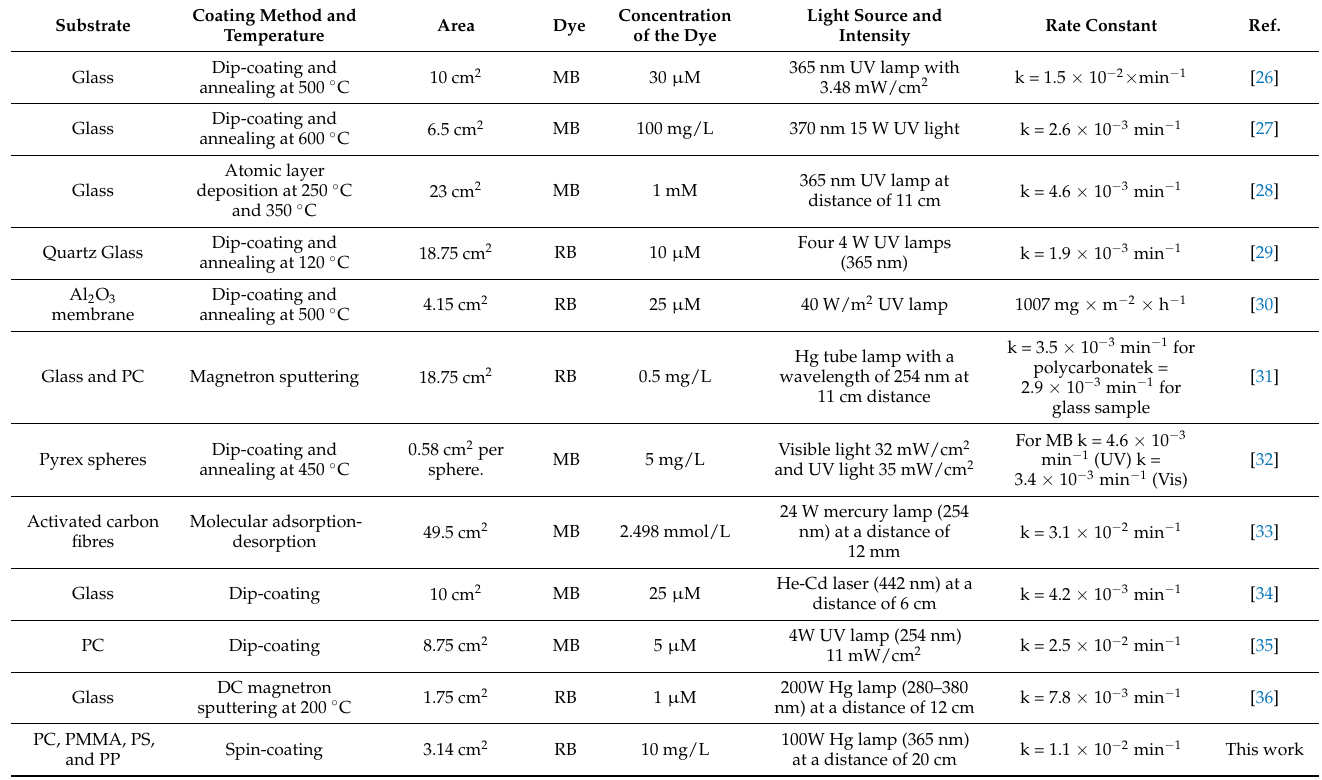
Table 1. Comparison of the different photocatalytic coatings found in the